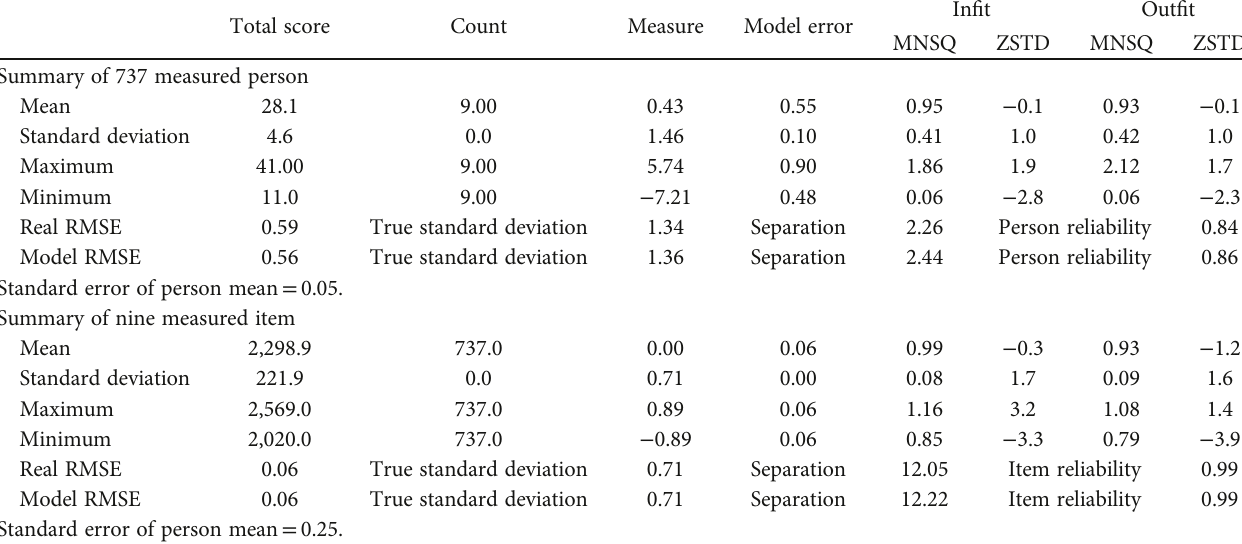
T ABLE 1: Summary of 737 measured person and item public opinion